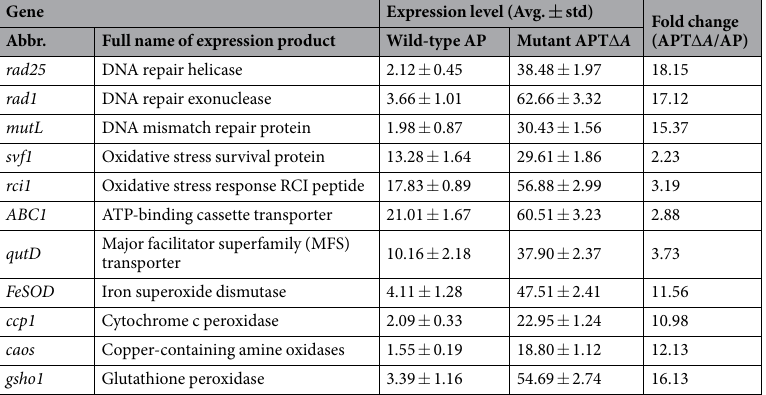
Gene Expression level (Avg. ± std)